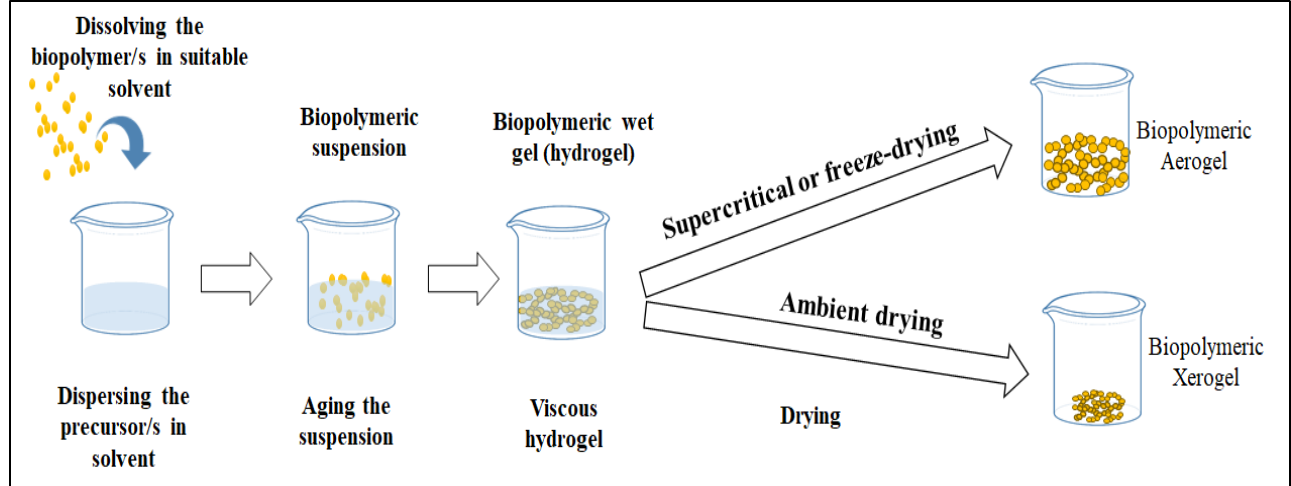
Figure 1. Schematic drawing of biopolymeric xerogel fabrication process and the difference be- tween xerogels and aerogels. xerogels and